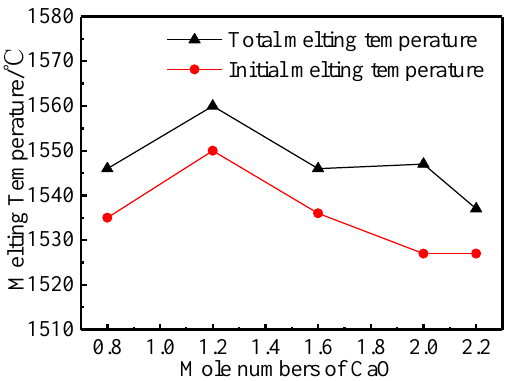
Figure 2. Melting properties of 6BaO·xCaO·2Al 2 O 3 aluminates.